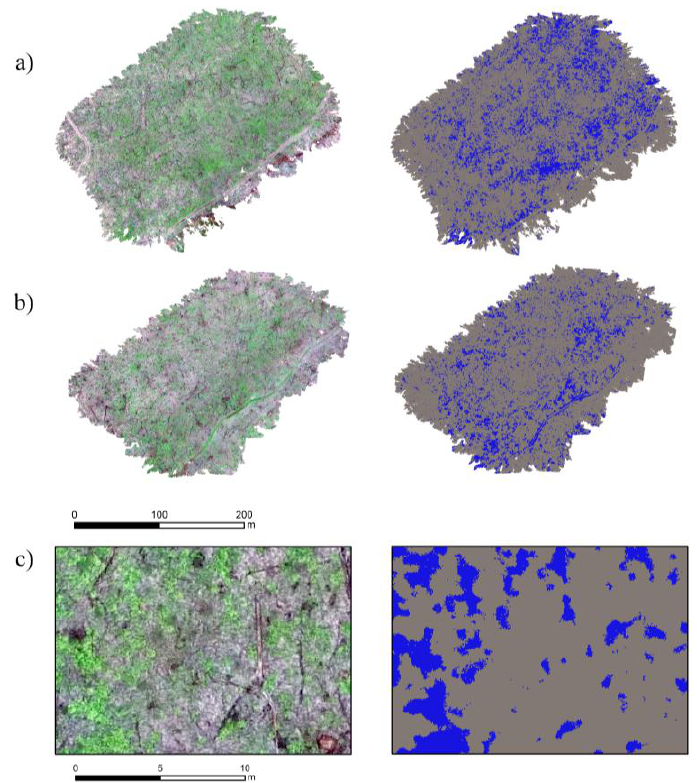
Figure 5. Comparison of the original orthomosaic (left) and the classification of wild leek based on the GCC threshold (right) for ( a ) Area 1, ( b ) Area 2, and ( c ) for a portion of Area 1.